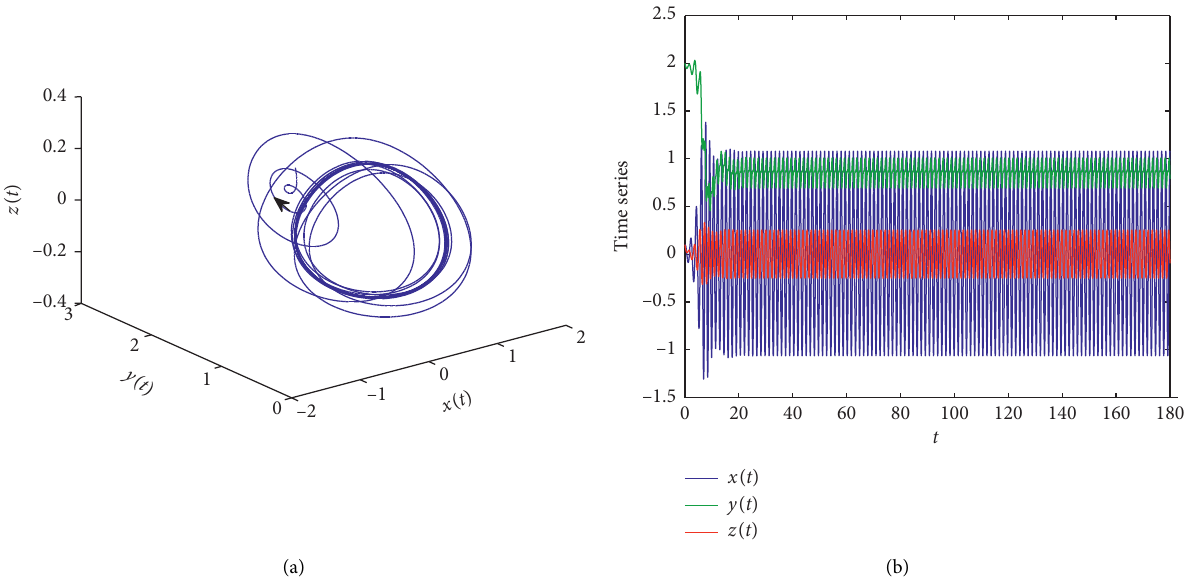
Figure 4: Phase space (a) and time series (b) of system (3a)–(3c) with initial value ( 0 . 1 , 2 , 0 . 1 ) for τ